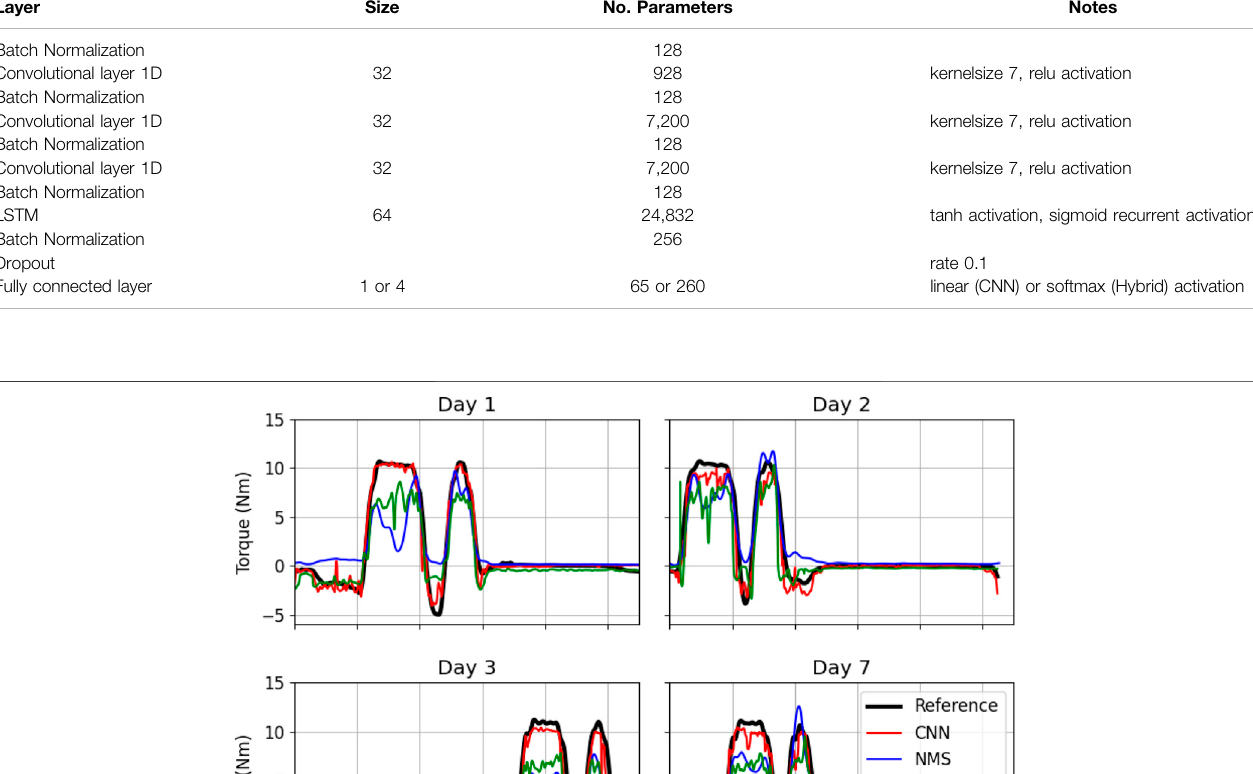
Frontiers in Robotics and AI |